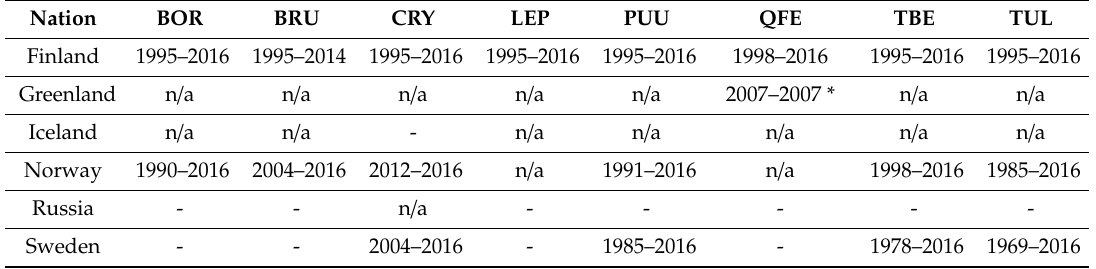
Table 1. Additional information concerning gender and age per nation and disease.